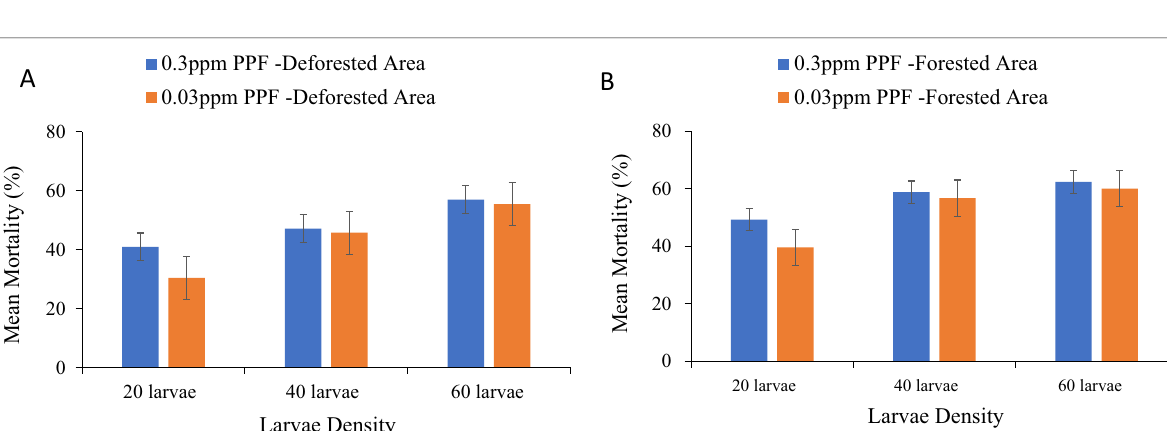
(Table 1 and 2). Pyriproxyfen treatment in larvae habi-